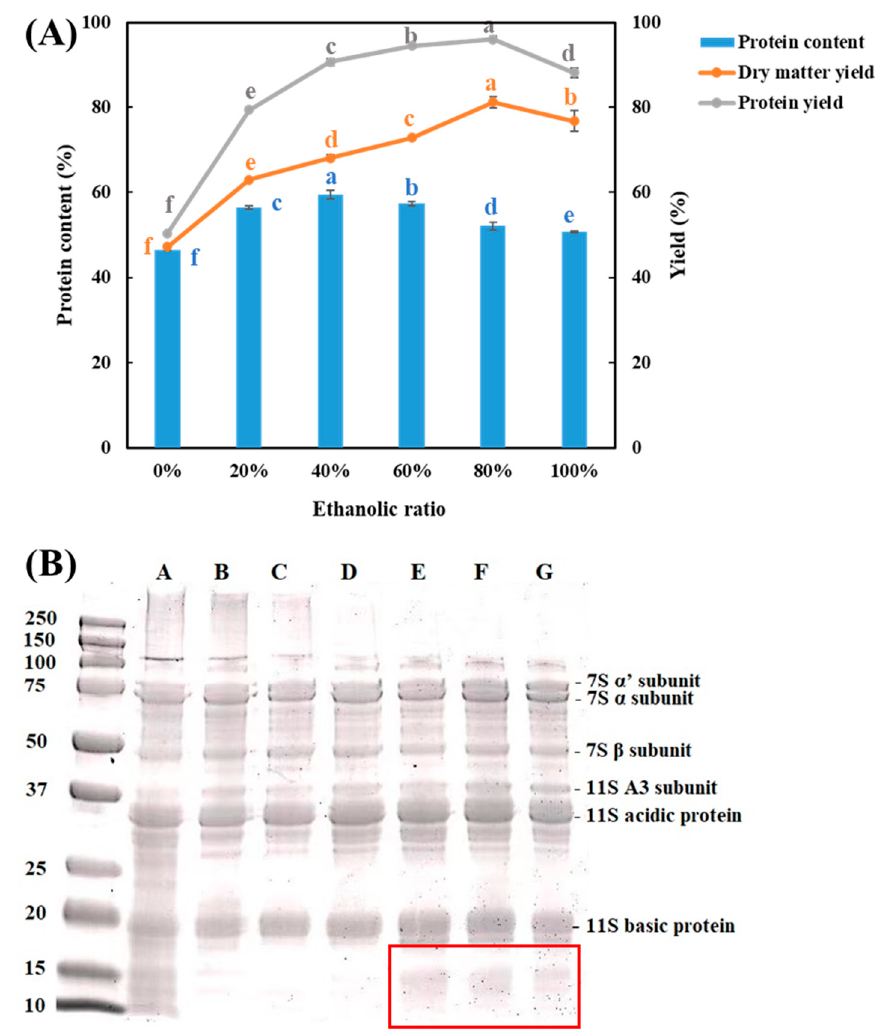
Figure 3. ( A ) Protein content, protein yield, and dry matter yield of all the soy protein concentrates (SPCs). The values in the figure are compared in series (same color) and different top letters (a,b,c,d,e,f) indicate a significant difference ( p < 0.05); ( B ) SDS-PAGE electrophoresis of soluble proteins in soy samples. Lane A, commercial SPC; Lane B–G, SPCs obtained by washing process with the water/ethanol ratios of 0%, 20%, 40%, 60%, 80%, and 100%.